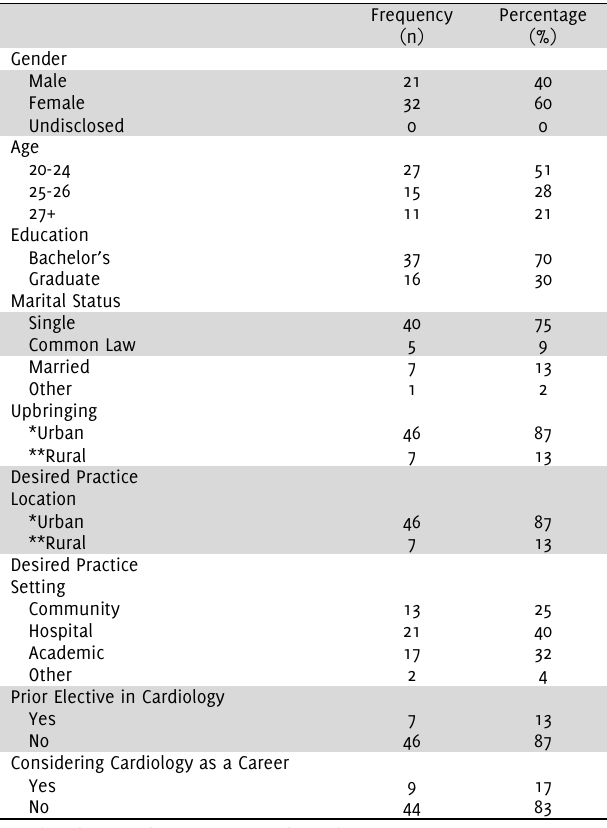
Table 1 . Demographic Characteristics of Respondents (n = 53).